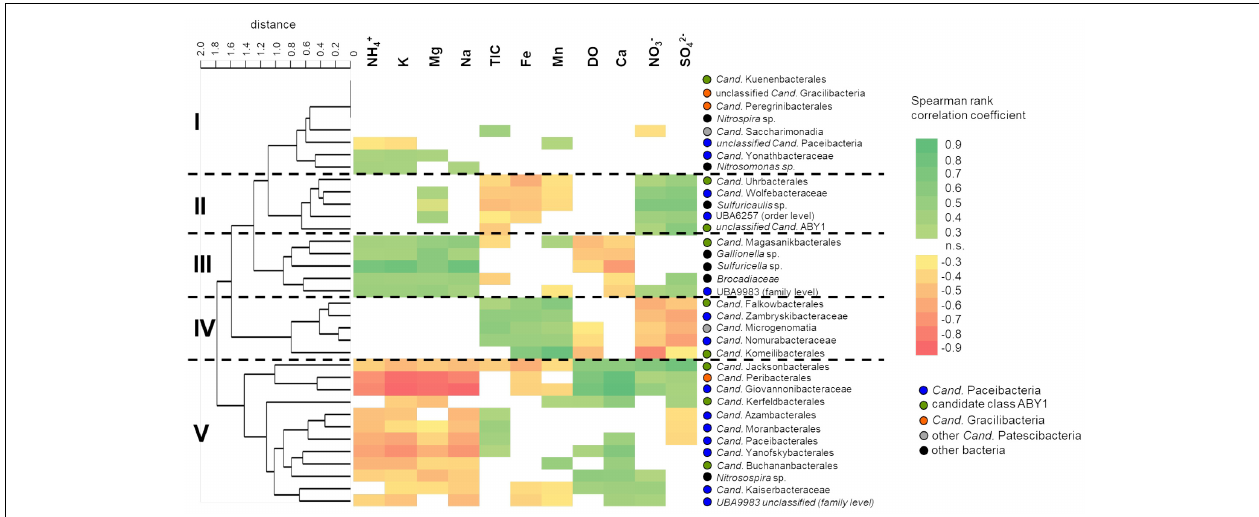
FIGURE 6 | Correlation of selected class-, order- and family- level bacterial groups with environmental parameters across the two aquifer assemblages. Correlations were calculated using Spearman rank correlation coefficients (r S ) with acceptance of significance at p < 0.05, n = 46. Colors indicate strength of correlation from r S = 0.9 to r S = –0.9. Taxa were clustered according to similar patterns in their correlation with environmental parameters using paired group algorithm (UPGMA) and Euclidean similarity index. DO, dissolved oxygen; TIC, total inorganic carbon.